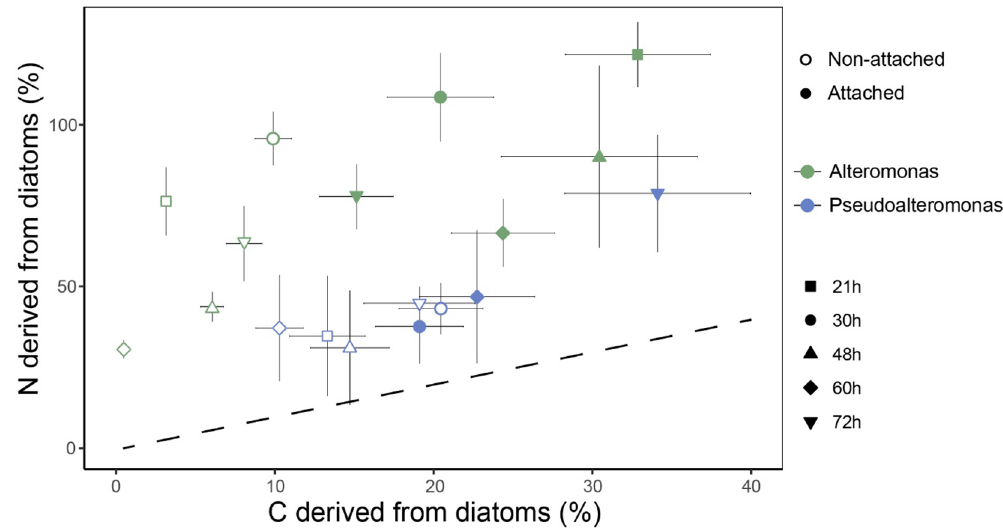
Figure 4. Averaged proportion of diatom-derived N (DDN) as a function of diatom-derived C (DDC) in the biomass of Pseudoalteromonas (blue dots) and Alteromonas (green dots) cells in aggregates physically attached (filled dots) or non-attached (empty dots) to diatoms (213 bacteria analyzed in total). Each dot represents one of the five time points. Dashed line indicates a 1:1 ratio between